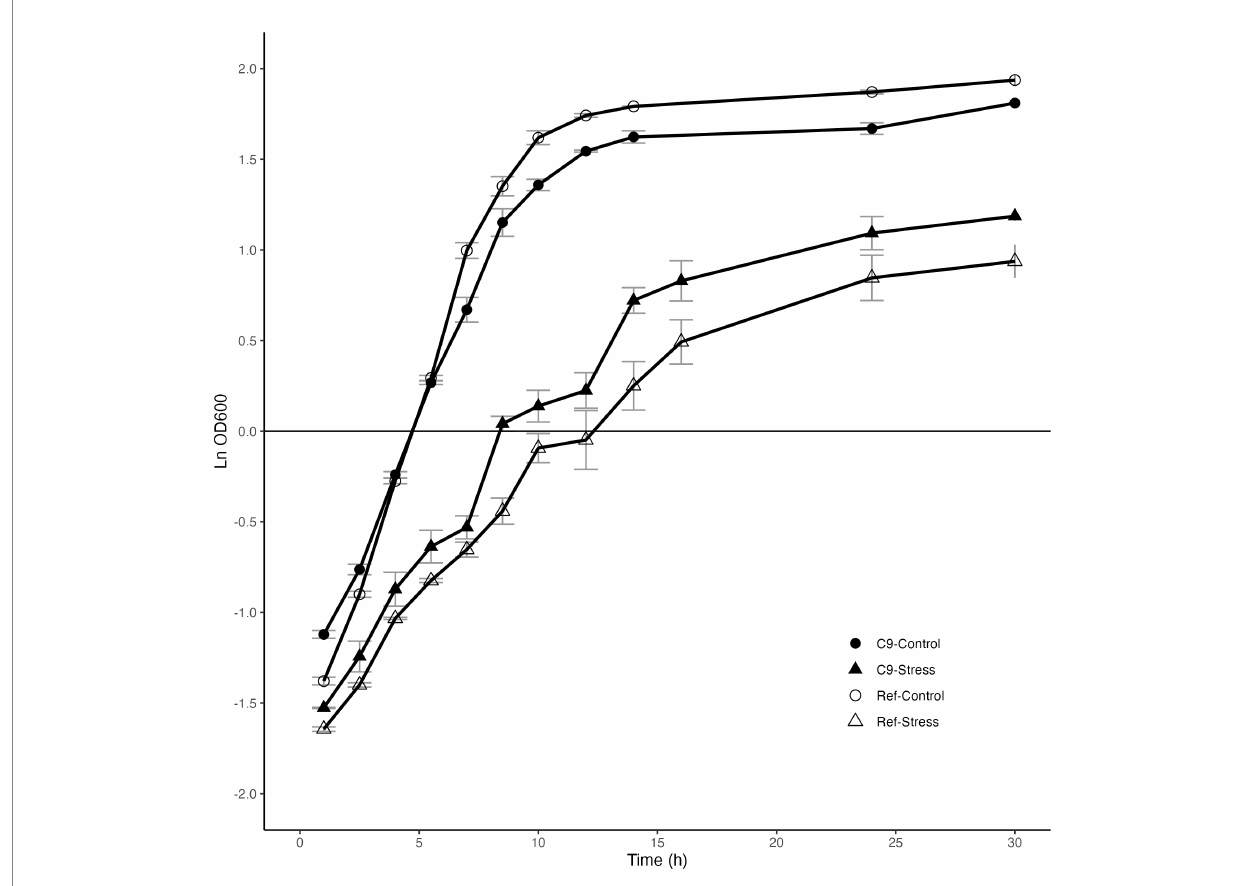
FIGURE 3 Growth behavior of the reference strain (Ref) and the evolved strain C9 in the absence and presence of 3 g/L 2-phenylethanol